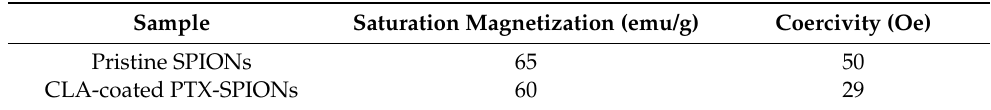
Table 1. Saturation magnetization and coercivity of pristine SPIONs and the CLA-coated PTX-SPIONs as determined by VSM